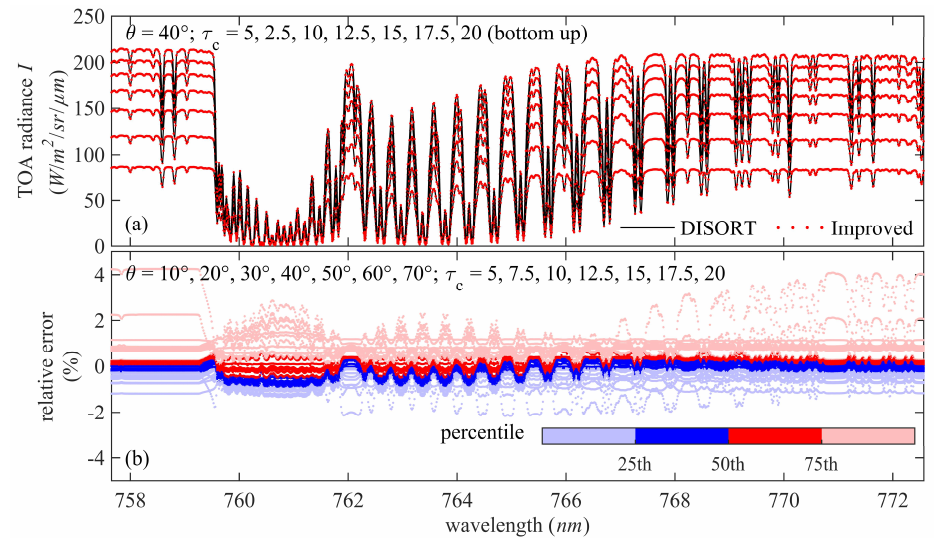
Figure 8. A series of TOA radiances, simulated at different cloud optical depths compared with the precise radiance derived from DISORT. ( a ) The radiance outside the oxygen A-band increases with the thickening cloud optical depth. ( b ) The relative error of the simulation outside the oxygen A-band. Each channel has 49 samples to estimate percentiles.